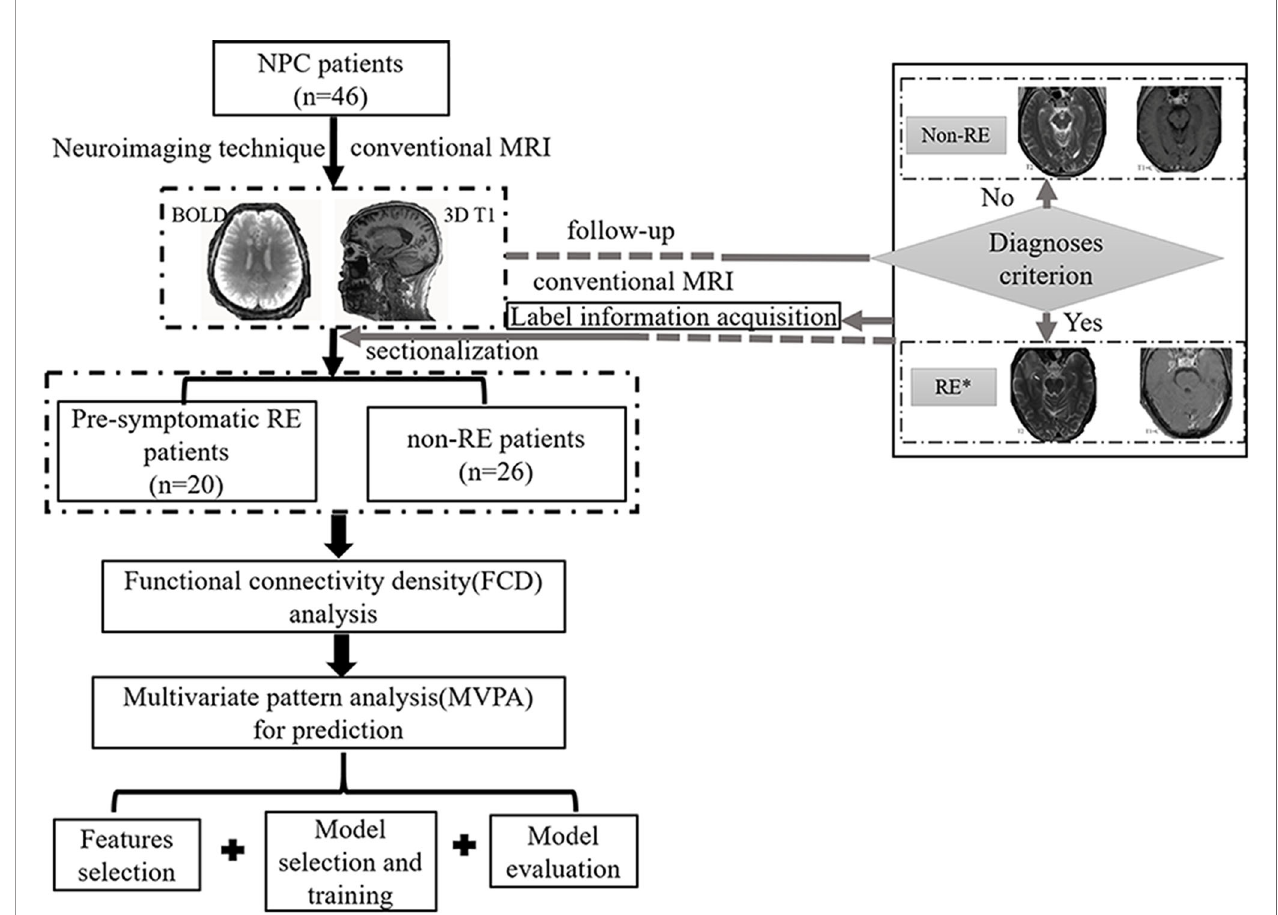
FIGURE 1 | The fl owchart of this study. *, patients with radiation encephalopathy were con fi rmed by Merritt ’ s Neurology; NPC, nasopharyngeal carcinoma; RE, radiation encephalopathy; BOLD, blood oxygen level-dependent; T2, T2 weighted image; T1+C, T1 weighted image +